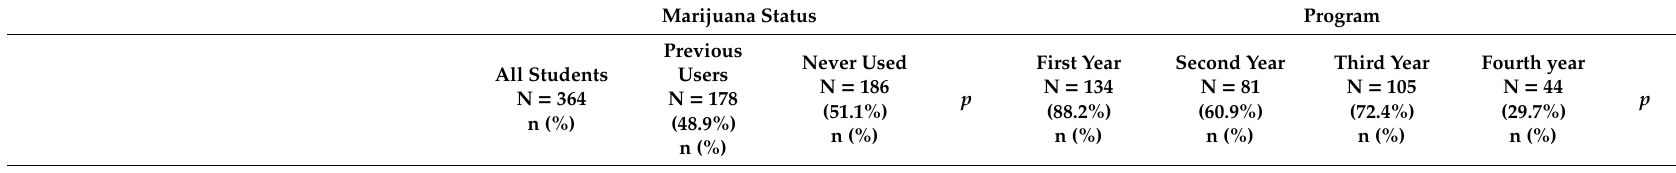
Table 3. Adverse e ff ects of cannabinoid-based medicines authorized in European Union countries. Students were asked about which of the adverse e ff ects indicated were adverse e ff ects associated with cannabinoid-based medicines. Statistical significance ( p < 0.05) was determined by chi-square